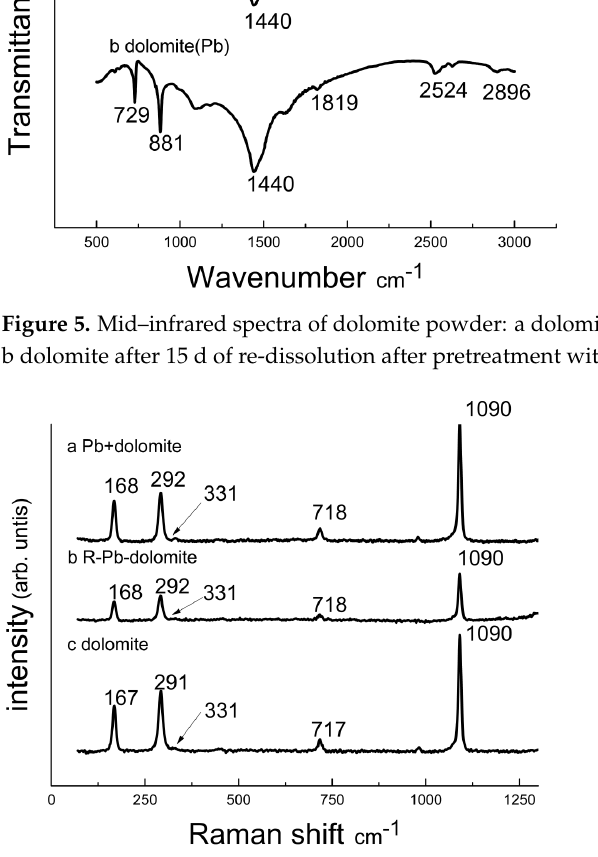
Figure 6. Raman spectra of dolomite powder: a, dolomite after 15 d exposure to PbCl 2 solution; b, dolomite after 15 d re-dissolution by treatment with PbCl 2 solution; c, initial